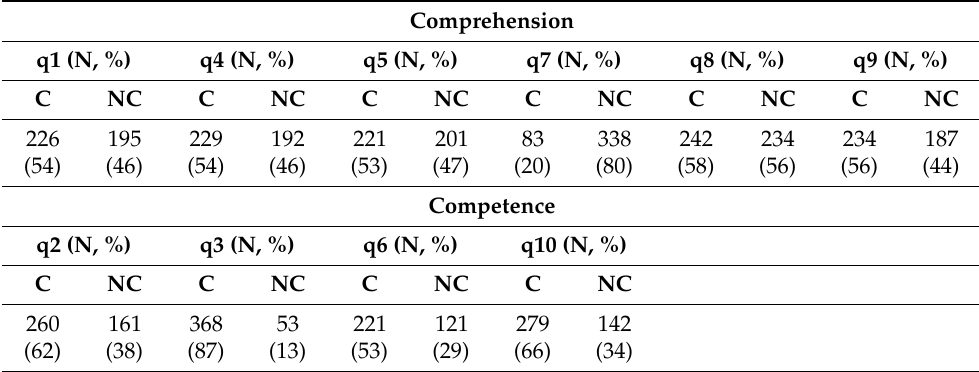
Table 5 categorises the ten questions into two groups: (a) comprehension (q1, q4, q5, q7, q8, q9) and (b) competence (q2, q3, q6, q10), and shows the number of respondents who answered each question correctly. Table 5. Participants’ score in each question of the Scientific English